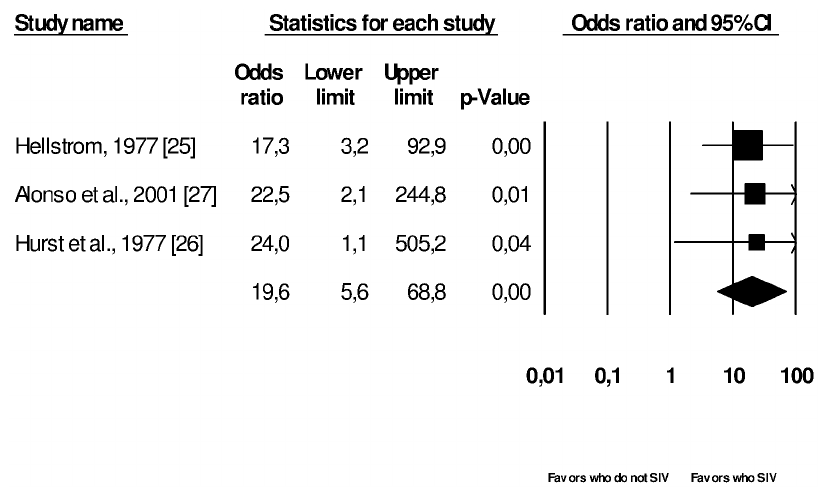
Figure 2. Meta-analysis of three cross-sectional studies associating tooth erosion with patients with eating disorders without self- induced vomiting (SIV) vs. eating disorders with SIV, with statistical significance; I 2 =0.0%, fixed effect model used.